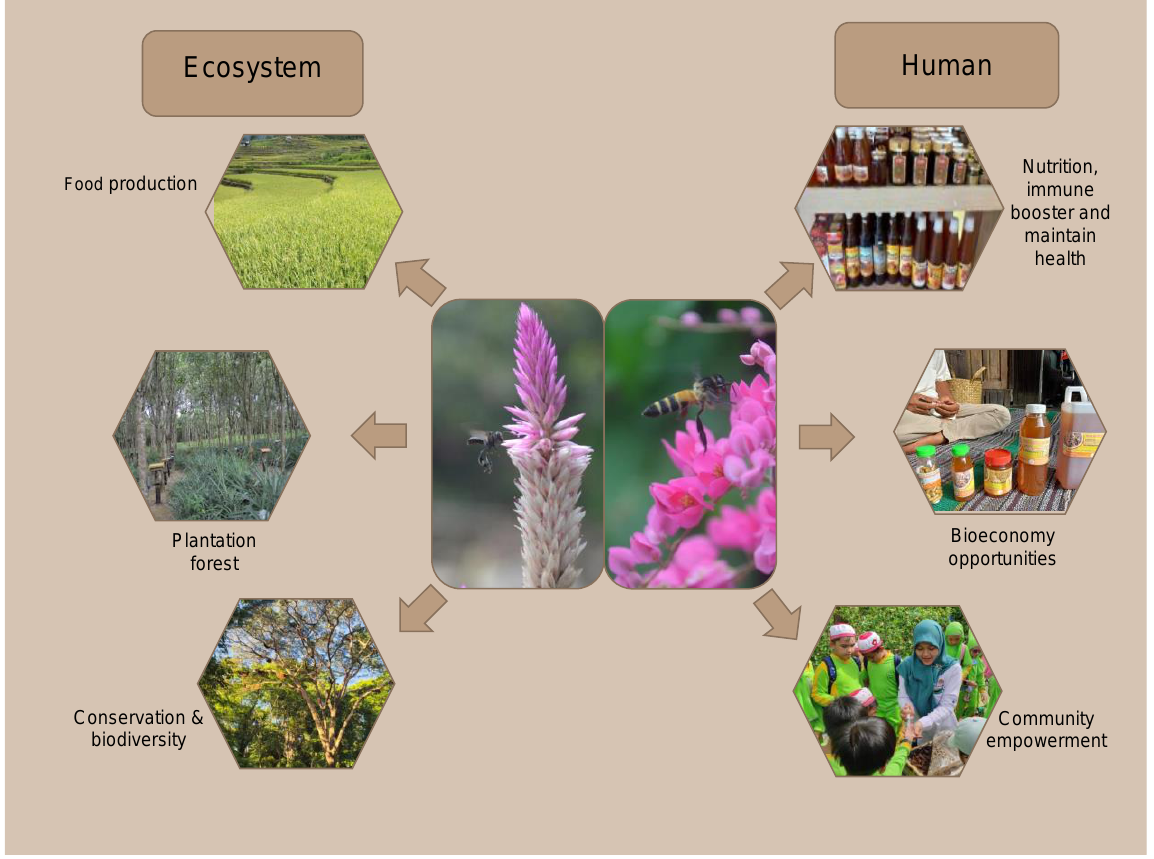
Figure 4. The role of bees’ contribution to bioeconomy and sustainable development targets (modified from [79]).